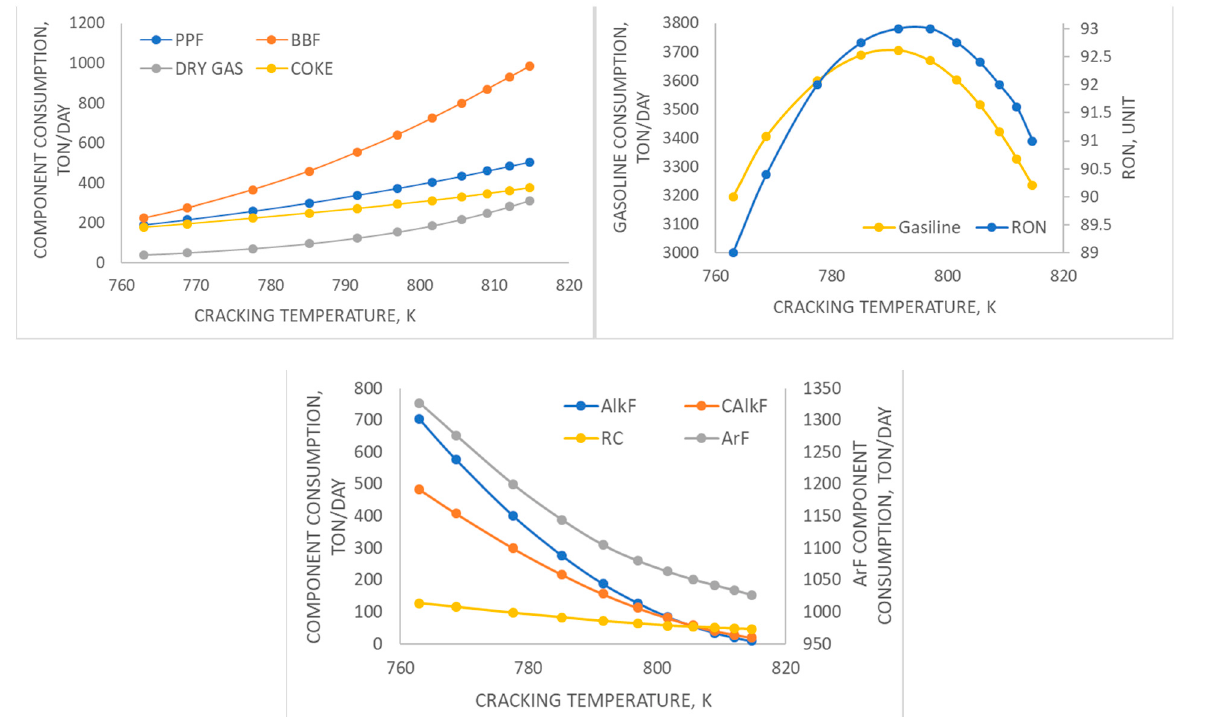
Figure 5. Effect of the main process variables on cracking temperature.